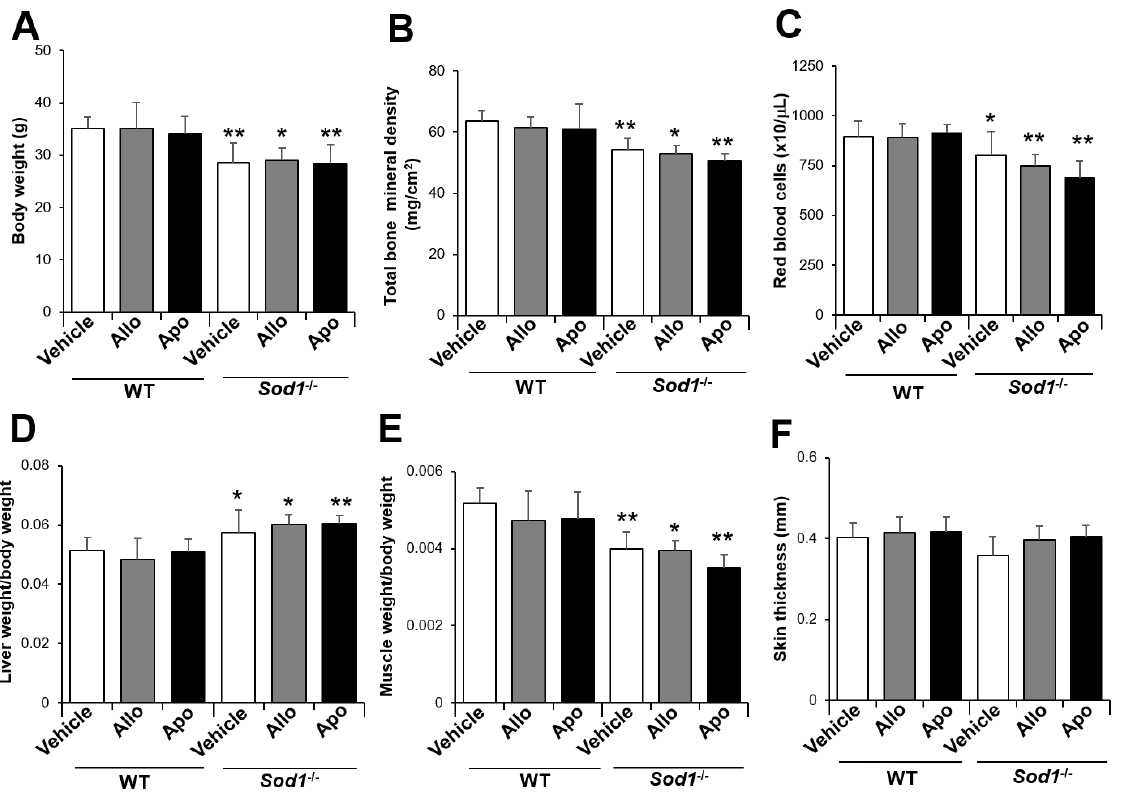
Figure 4. Administration of allopurinol to aged Sod1 − / − male mice. The body weight ( A ), total bone mineral density ( B ), red blood cell count ( C ), ratio of liver weight/body weight ( D ), ratio of muscle weight/body weight ( E ), and skin thickness ( F ) of WT and Sod1 − / − male mice (12 months of age, n = 4–5) administered allopurinol or apocynin for 8 weeks. * p < 0.05, ** p < 0.01. Data are shown as the mean ± SD.